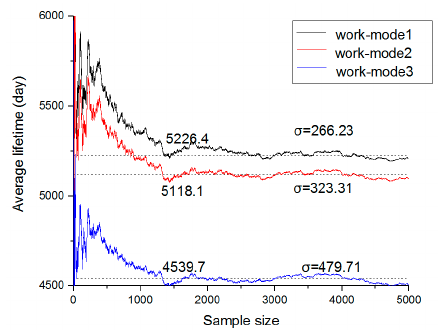
Figure 25. Life prediction of the FS with Configuration 2 in different work modes.